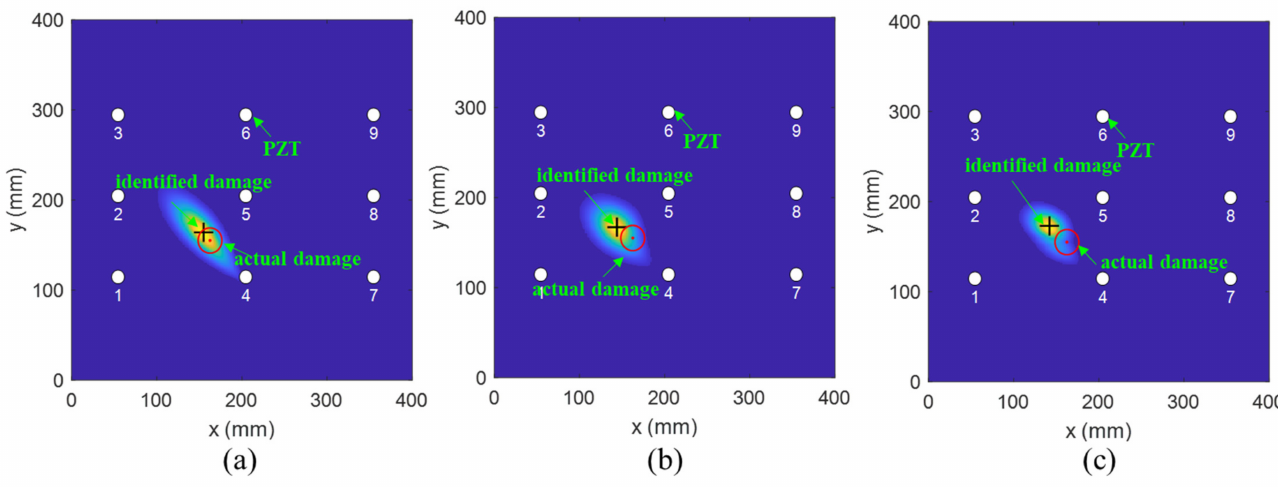
Figure 21. The imaging results of one virtual damage at location (162 mm, 155 mm) obtained by ( a ) the modified PDI method, ( b ) the fused PDI method, and ( c ) the conventional PDI